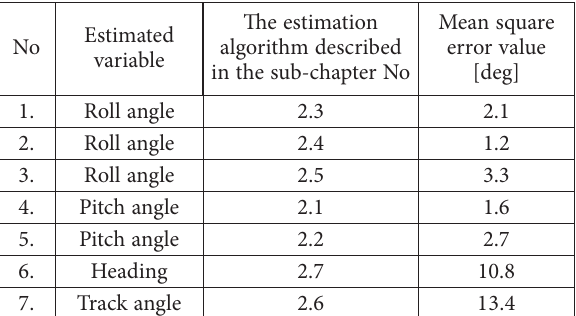
Figure 9. Aircraft track angle [deg] estimation – algoritm is described in sub-chapter 2.6 Table 1. Mean square error of